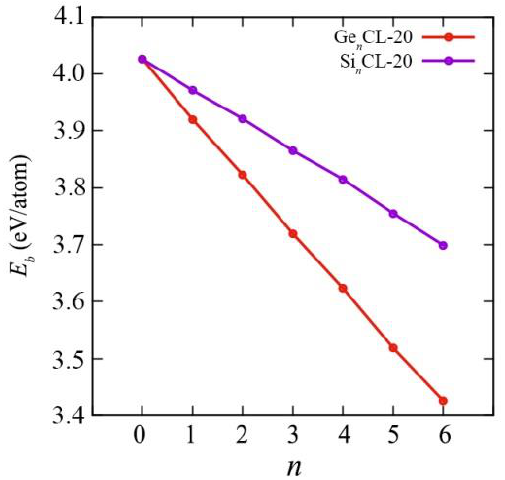
Figure 5. The binding energy versus the number of Si-/Ge-atoms n in the SinCL-20/GenCL-20 molecule for the most thermodynamically stable configurations obtained at the DFT/B3LYP/6-311(d,p) level of theory.